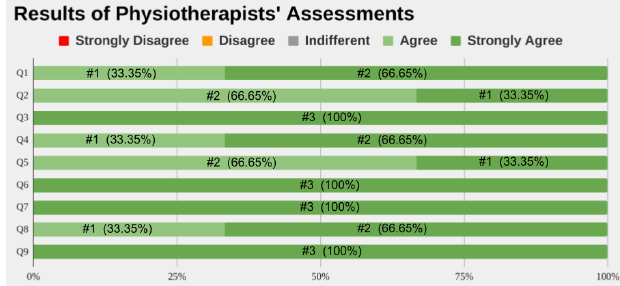
Figure 15. The physical therapist’s results summarized. Source: Author